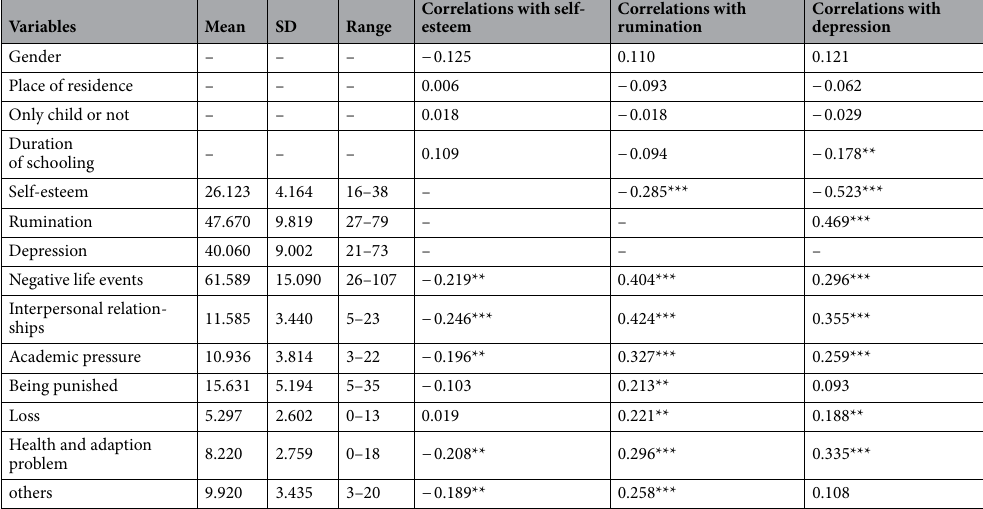
Table 1. Means, Standard Deviations, Range of the study variables and Bivariate Correlations among them. N = 236. Duration of schooling means that the time the participants studied in the correctional